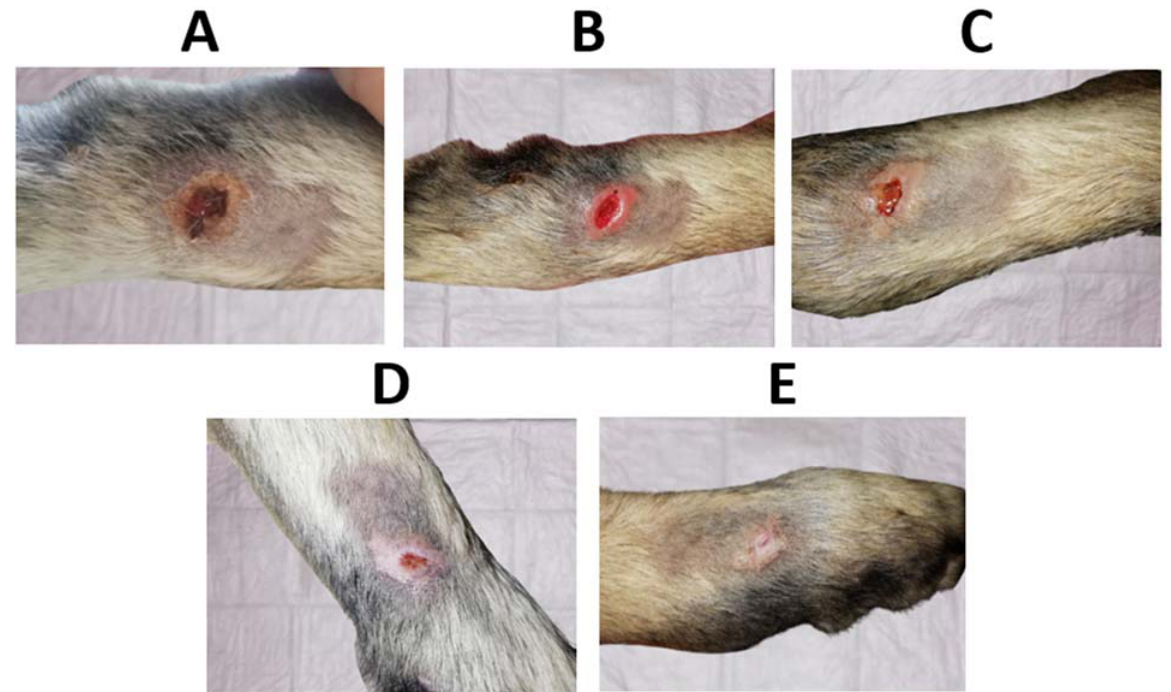
Figure 11. ( A ) Initial dorsolateral wound on the right pelvic limb, ( B ) wound on day 5, ( C ) wound on day 9, ( D ) wound on day 11, and ( E ) wound after 15 days of treatment without antiseptic-loaded casein hydrogels.